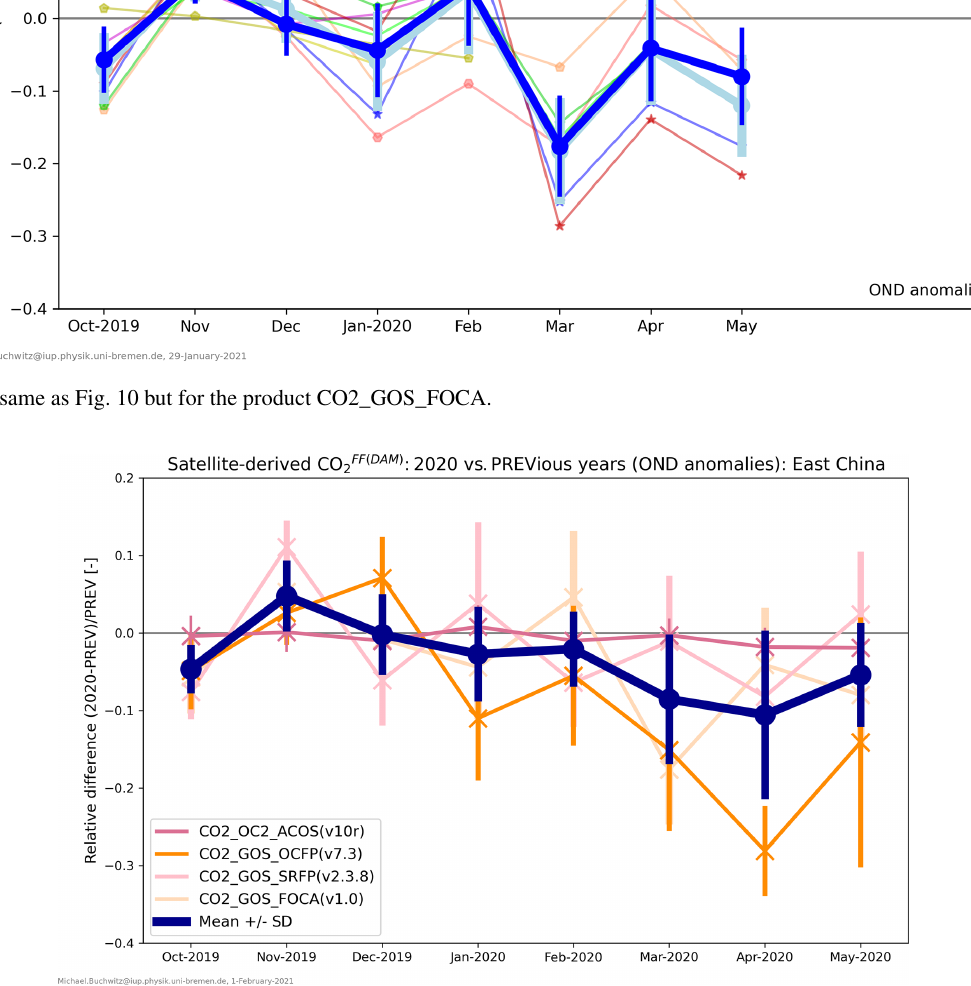
Figure 13. Overview of the ensemble-based CO FF ( DAM ) results for January–May 2020 relative to October–December 2019 and previous 2 years (also shown in Figs. 9–12) via reddish colours for each of the four analysed satellite XCO 2 data products (see Table 1). The corre- sponding ensemble mean value and its uncertainty is shown in dark blue. The uncertainty has been computed as the standard deviation of the ensemble members. The corresponding numerical values of the ensemble members are listed in Table